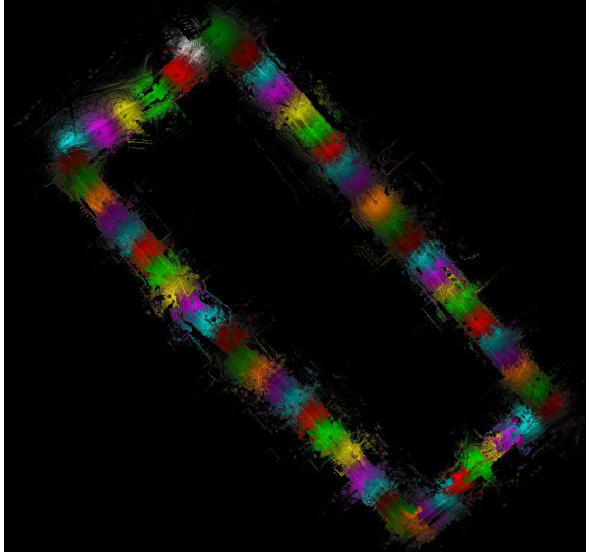
Figure 5. Nine ground control points were measured around the test site. (Background map data © City of Figure 4. Top view of the 58 TLS point clouds covering the Espoonlahti test field.